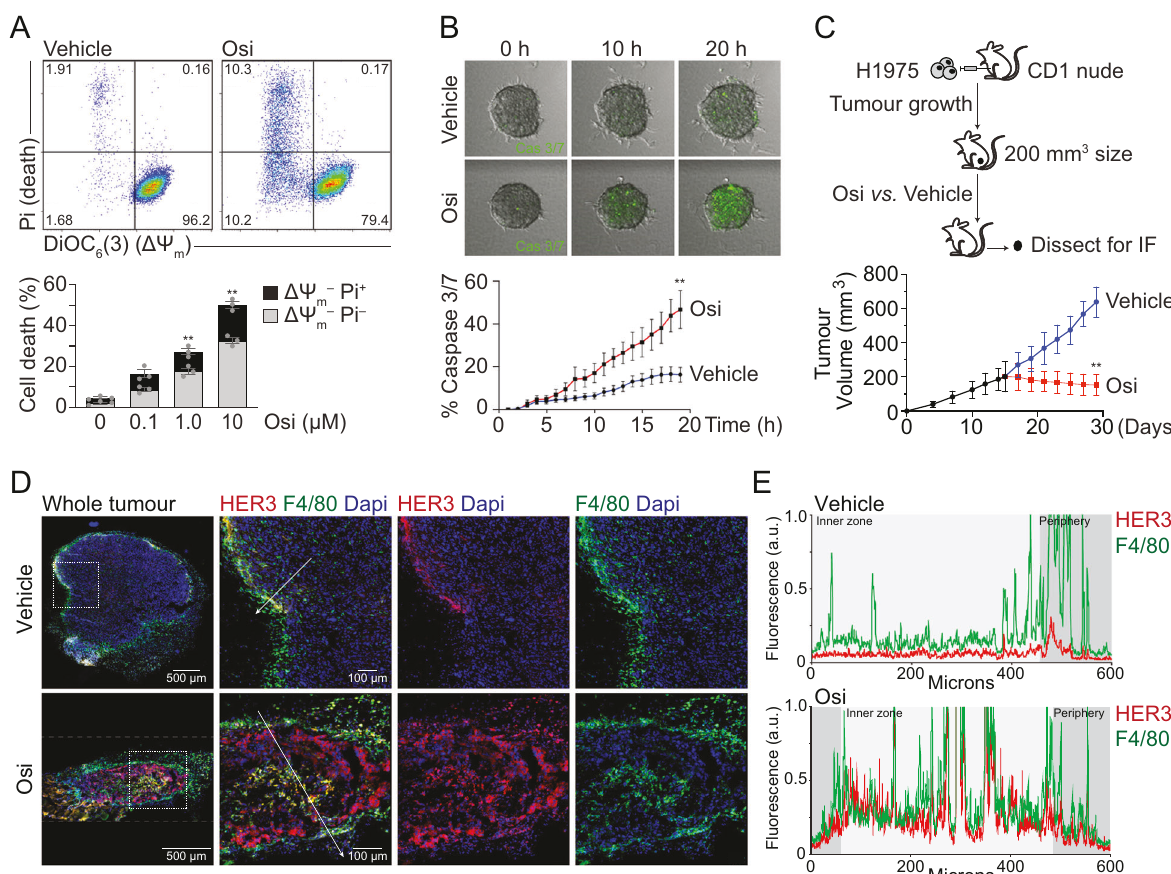
Fig. 1 Osimertinib triggers apoptosis in 2D, 3D and in vivo models, leading to HER3 upregulation and macrophage tumour-in fi ltration. A H1975 cells were treated in 2D at the indicated osimertinib (Osi) concentrations for 24 h; apoptosis was measured using fl ow cytometry with DiOC 6 (3) for mitochondrial transmembrane potential ( ΔΨ m ) and PI for viability, as described in materials and methods. Representative dot plots show vehicle vs. 0.1 μ M osimertinib-treated cells; the graph shows mean ± SEM of three experiments. ** P < 0.01 vs . vehicle (0 μ M) as indicated, using unpaired t -test with total values. B H1975 3D spheroids were treated with 200 nM osimertinib. The apoptotic activation of caspases 3/7 was monitored by fl uorescence time-lapse microscopy. ** P < 0.01 vs . vehicle as indicated using t -test; data shown as mean shows mean ± SEM of three replicate experiments. C In vivo xenograft diagram: 2.5 × 10 6 H1975 cells were injected in 8 CD1-nude mice and tumor sizes were measured until 200 mm 3 -tumors were established. Vehicle vs . osimertinib oral gavage [5 mg/kg/day] groups were treated, and tumors were dissected after 10 days for immuno fl uorescence microscopy studies. The graph shows tumor growth curves, means ± SEM, ** P < 0.01 vs . vehicle as indicated using t -test. D Confocal immuno fl uorescence images from xenograft tumor slices, showing HER3 distribution (red) and macrophages stained with F4/80 (green). Representative images are shown from 3 independent tumors; white scalebars as indicated. E Line-scan analysis of fl uorescence intensities across the 600- μ m-long white arrows from the merged channel images shown in D. For clarity, the inner vs . outer zones of tumors appear in the graphs as pale vs . darker grey respectively, showing increased HER3 levels and macrophage in fi ltration in the osimertinib-treated tumors. Graphs are representative from line-scans from 3 replicate on the undersides of lids of 15cm dishes using a multichannel pipette. The lids with hanging drops were put back onto PBS-containing dishes and cultured for 48h to allow spheroid formation. Spheroids were then carefully transferred onto 96 well plates previously coated with 50 μ L of collagen hanging drops and placed on the top centre of the collagen layers and left to settle for 45min in incubator; after this time Fluorobrite medium with apoptotic reporter dye (Cell event green caspase-3/7, according to manufacturer ’ s instructions; Thermo fi sher) in combination with vehicle (0.05% DMSO) or osimertinib (200nM) was added for spheroid treatment. Plates were imaged live using a fast acquisition confocal Nikon Eclipse Ti inverted microscope equipped with a Yokogawa CSU-X1 disk head, an Andor Neo sCMOS camera. Fluorescence of the apoptotic reporter was quanti fi ed using Fiji ImageJ.